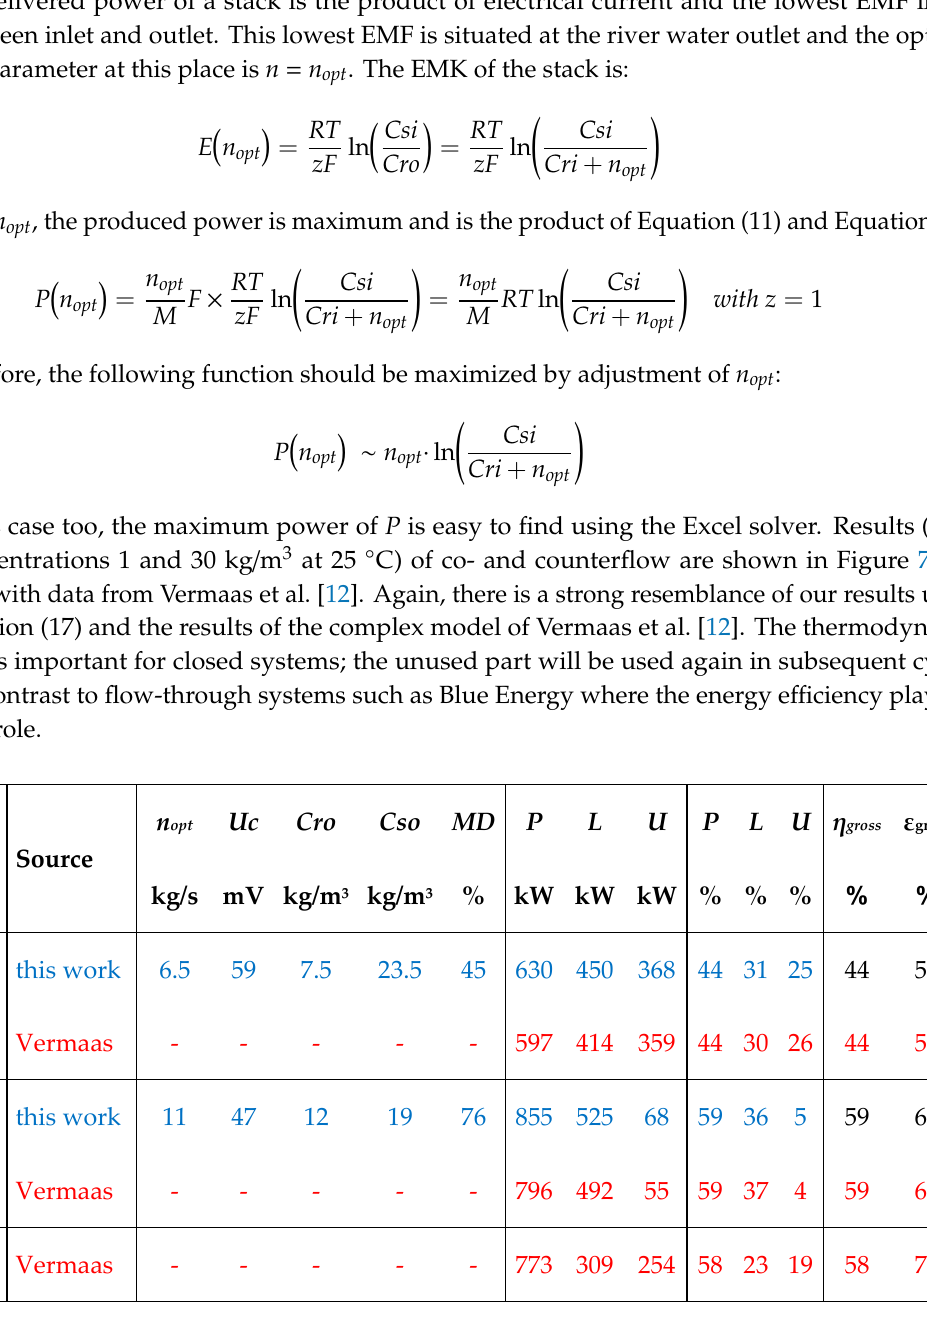
Figure 7. Results of this work for stacks with inlet concentrations 1 and 30 kg/m 3 compared with data of Vermaas et al. [12]. n opt stands for the optimal transport, U c for the clamp voltage, Cro and Cso for the river and seawater outlet concentrations, P for generated electrical power, L for loss and U for unused exergy; η gross and ε gross are the energy efficiency and the thermodynamic efficiency .